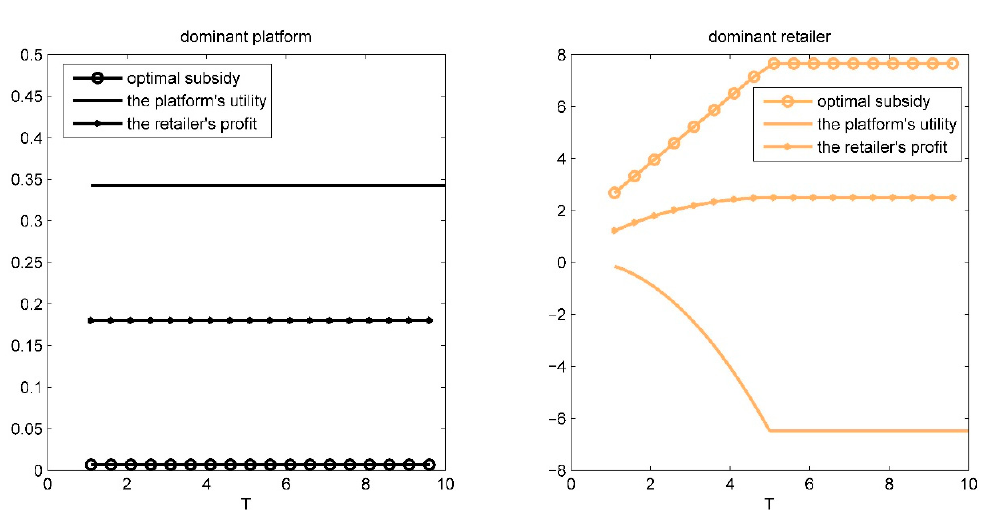
power structures with the change of T .